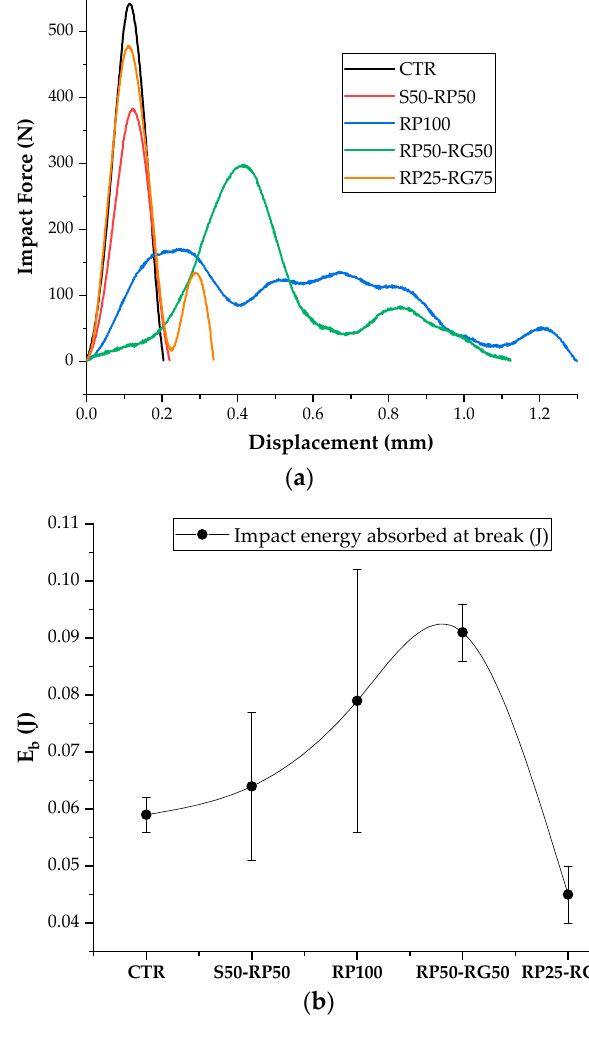
Figure 13. ( a ) Impact force–displacement curves and ( b ) impact energy absorbed at break: Test re- sults.